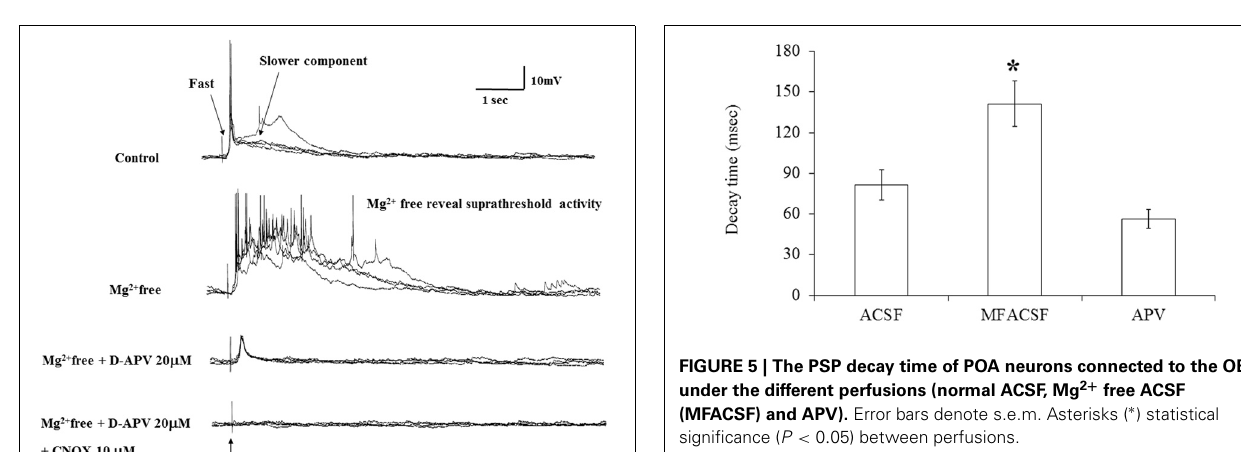
differences between groups. Results are presented as mean ± s.e.m. for convenience. Letters represent groups that differed significantly ( P < 0 . 005) from each other with Bonferroni corrections. (D) Soma capacitances of the different neuronal groups.